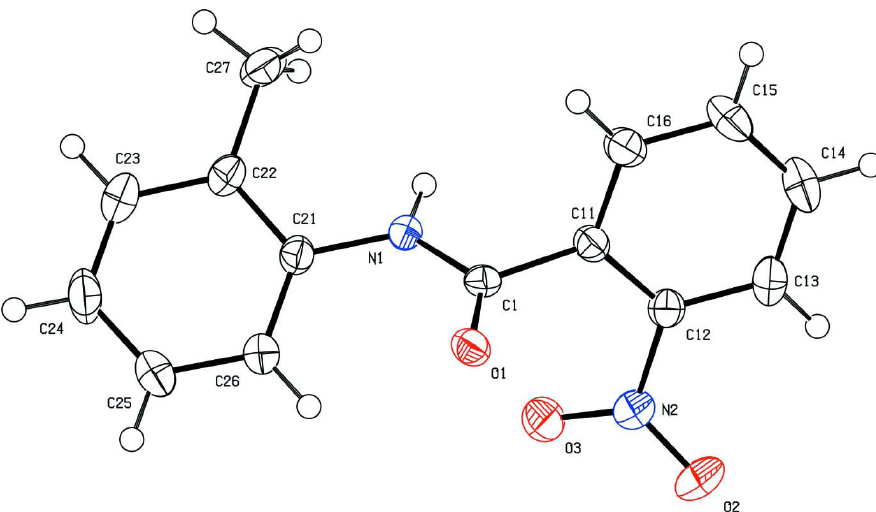
Figure 1 Molecular structure of title compound with displacement ellipsoids at the 50% probability level. N -(2-Methylphenyl)-2-nitrobenzamide Crystal